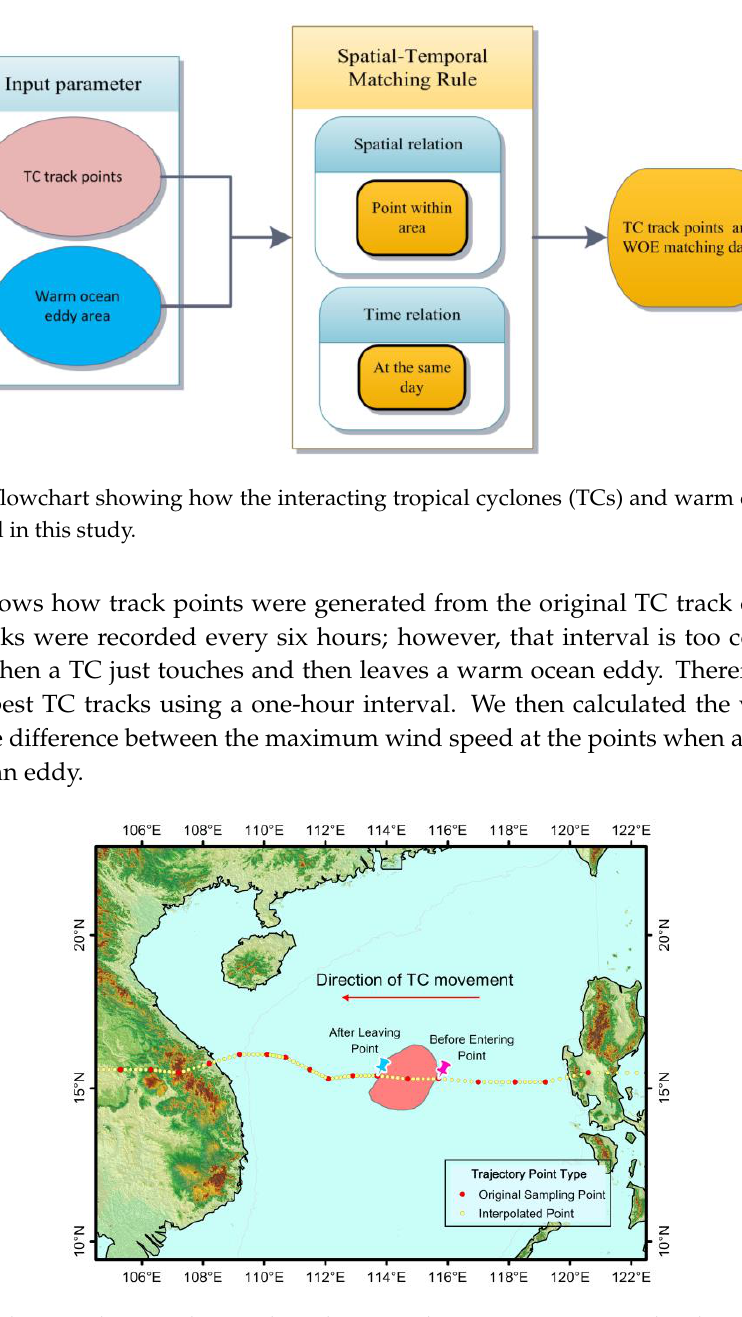
Figure 2. A schematic diagram showing how the TC track points were generated and used to calculate TC intensity variations before and after the eddy interaction. The red area in the center of the map represents the sea surface region extracted from a sea level anomaly map that belongs to a warm ocean eddy. The yellow line shows the TC tracks.